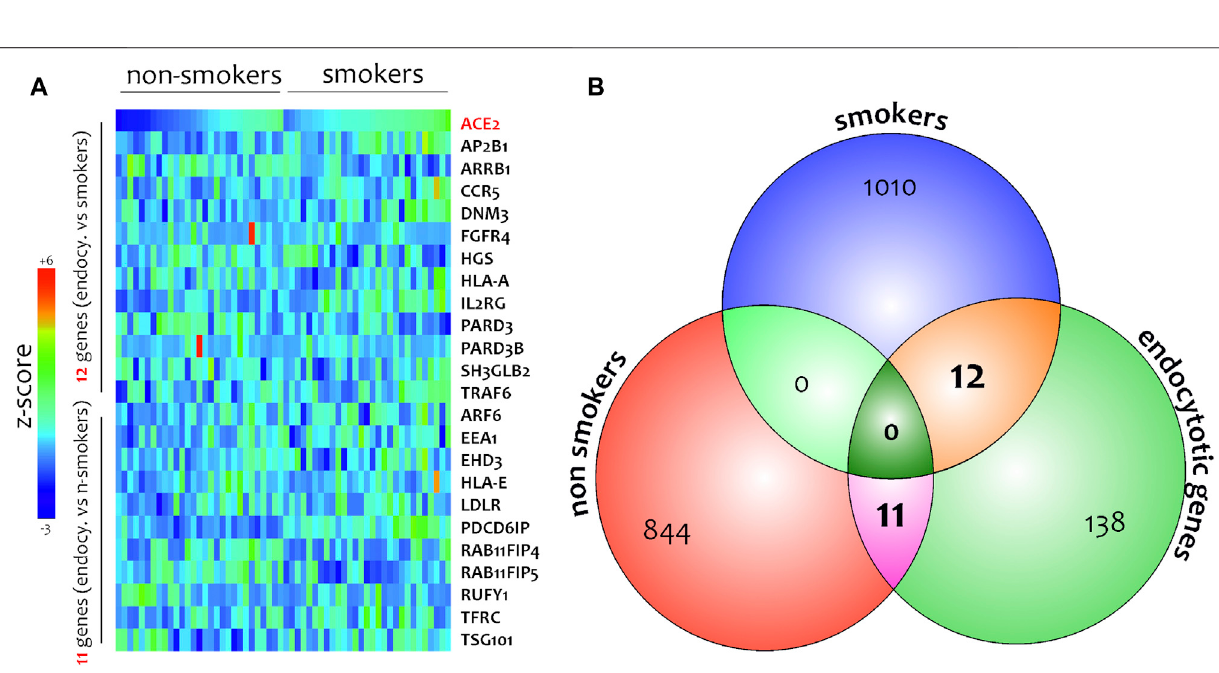
Frontiers in Pharmacology |